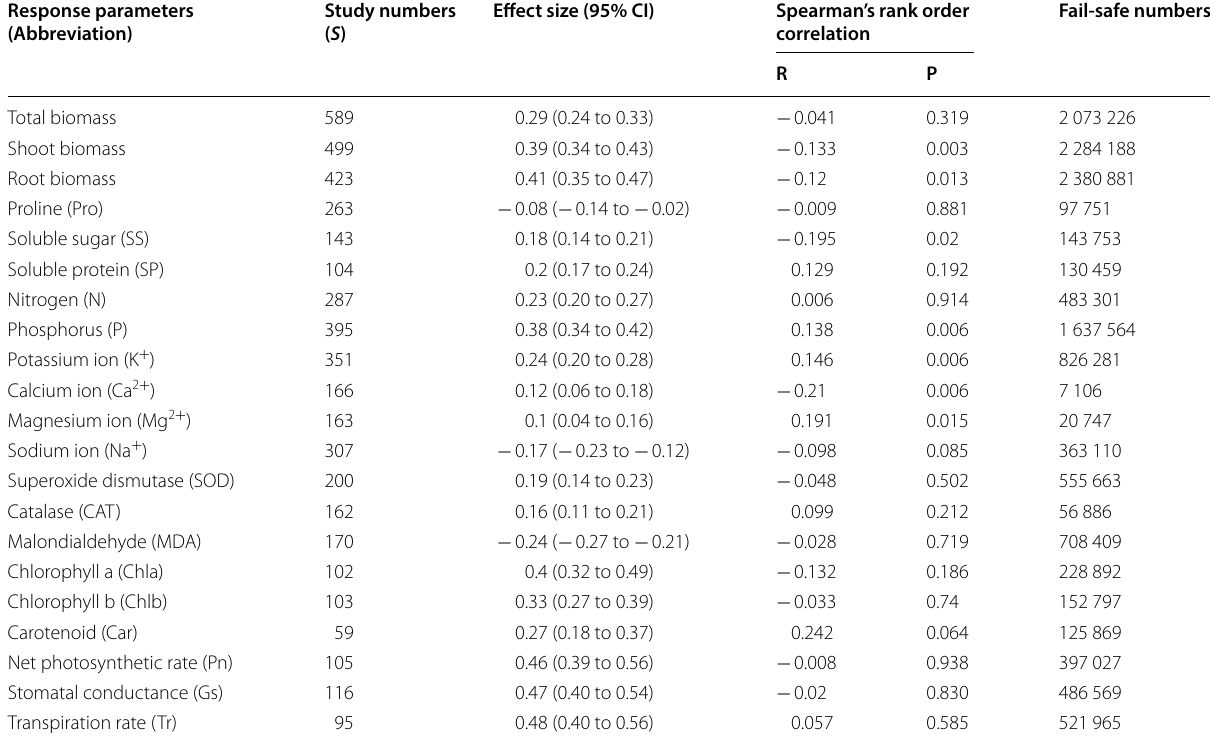
Table 1 Rank correlation tests and fail-safe numbers for publication bias Response parameters